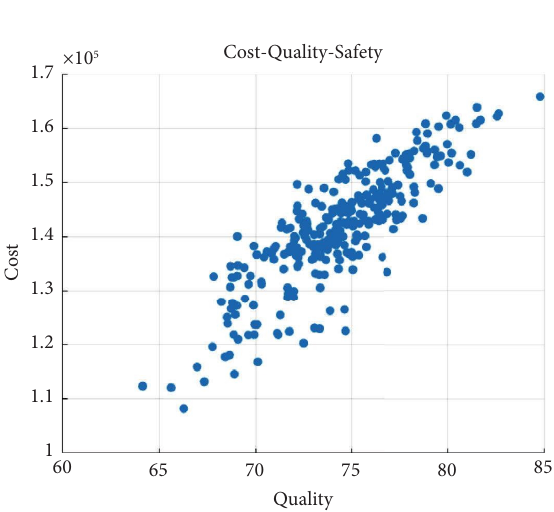
Figure 18: Cost-quality